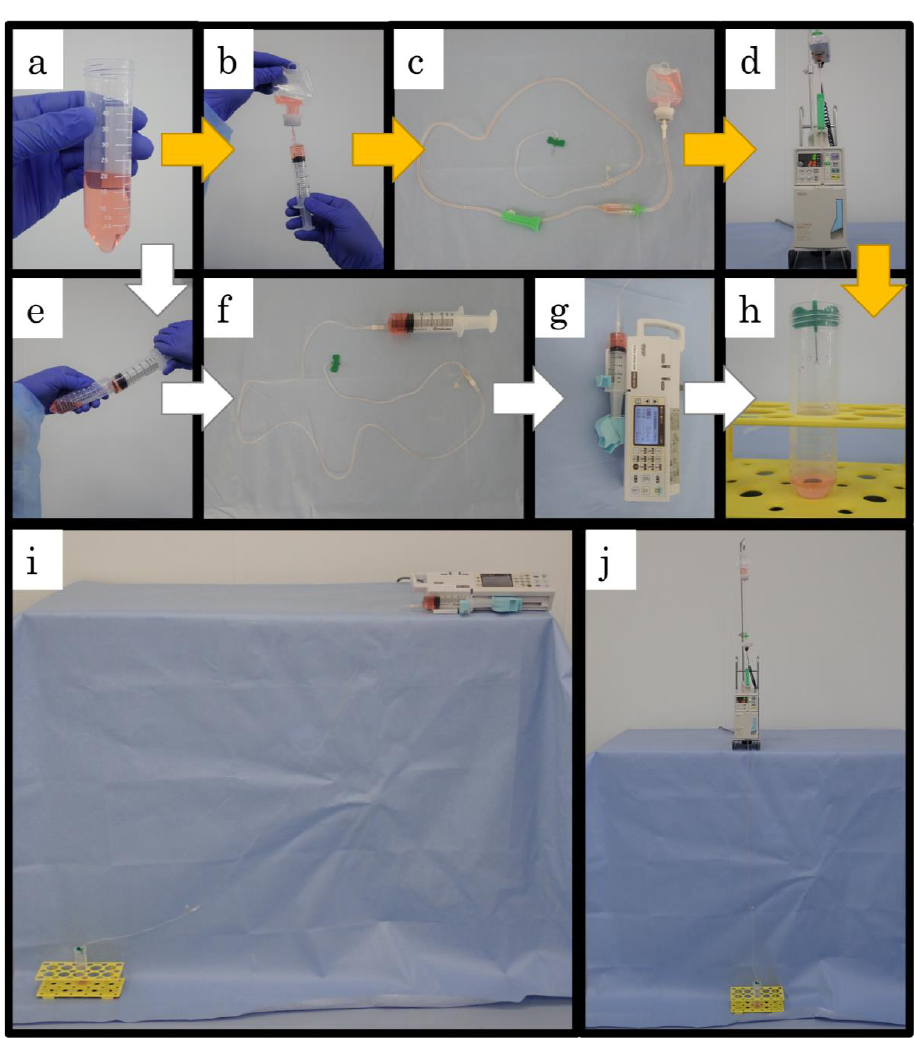
Figure 9. Outline the infusion procedures. ( a ), Suspend 1 × 10 7 cADSC in 20 mL NS to prepare a cell suspension with a density of 5 × 10 5 cells/mL; ( b ), The prepared solution is collected in a 25 mL syringe with an 18G needle and transferred to an empty 50 mL infusion bag; ( c ), The cell-containing bag is connected to the infusion tube with a 21G winged needle; ( d ), The bag is placed in a drop-controlled automatic infusion device; ( e ), The prepared solution is collected directly in a 50 mL syringe with an 18G needle; ( f ), the cell-filled syringe is connected to an extension tube with a 21G winged needle; ( g ), the syringe was placed in a syringe pump; ( h ), The winged needle tip is placed in a conical tube and the infused cells were collected. The conical tubes are replaced every 15 min, mixed immediately by gentle inversion; ( i ), Overall view of an infusion using a syringe pump. The conical tube for collecting the flowing cell suspension is placed lower than the syringe pump and the extension tube is not deflected; ( j ), Overall view of an infusion using an infusion device. The cell suspensions in this series of photographs are stained red for photography to visualize suspension transfer. Yellow arrow: infusion procedure using an infusion device; White arrow: infusion procedure using a syringe pump.